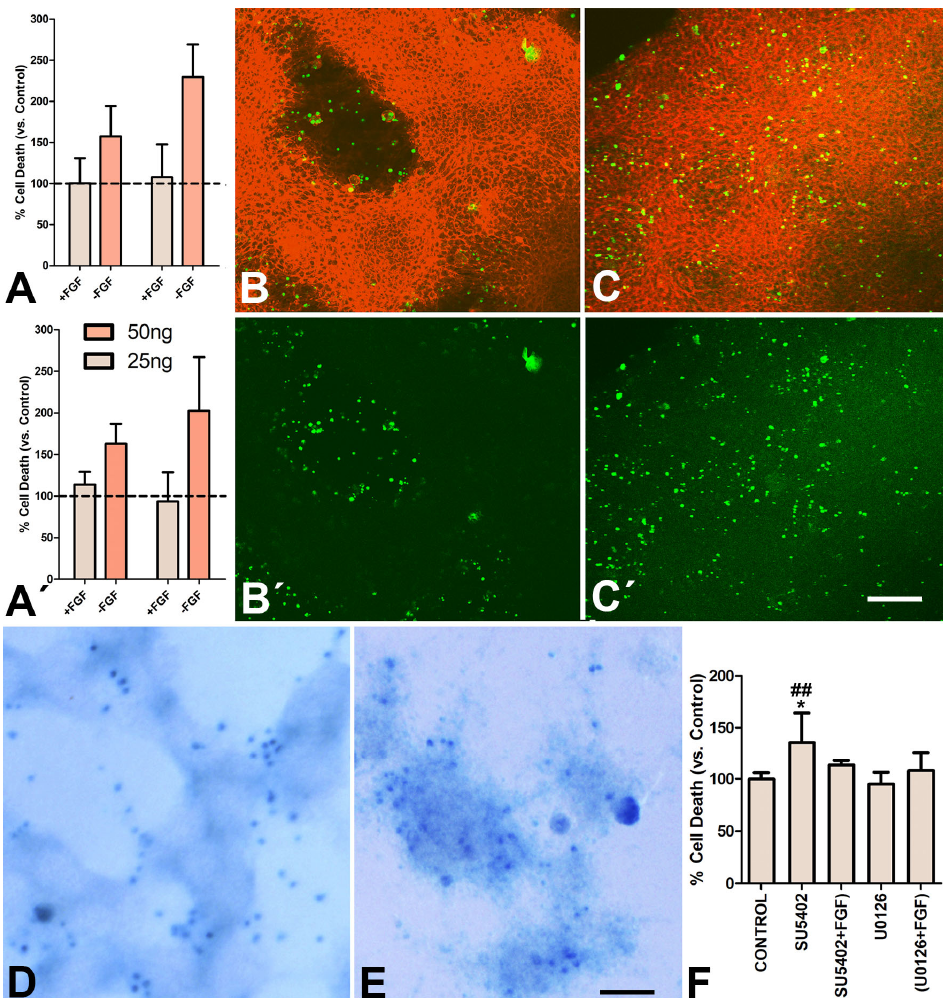
Figure 3. (A – A’) Graphic representation of the rate of cell death evaluated by flow cytometry in cultures treated for 2 days with 25 (light columns) or 50 ng/mL of FGF2 (red columns) to compare the effects of a continuous treatment with FGF (+FGF) and the effect of FGF withdrawal ( ‐ FGF) for 3 h ( A ) or 6 h ( A’ ). The rate of cell death in the control untreated micromasses was considered 100 and is indicated by the dotted line. (B – B’) Confocal view of the perinodular arrangement of TUNEL ‐ positive cells (green labeling) in a labeled control 2 ‐ days culture. The sample is also labeled with phalloidin (red labeling). ( B ) is a merged image, and ( B’ ) shows only the green channel. ( C – C’ ) Confocal view showing the widespread arrangement of TUNEL ‐ positive cells (green labeling) after 3 h of FGF withdrawal in micromasses treated for 2 days with FGF2 (25 ngr/mL) . Red labeling corresponds to phalloidin. ( C ) is a merged image, and ( C’ ) shows only the green channel. ( D , E ) Detailed view of the SA β‐ gal arrangement in control ( D ) and experimental micromasses subjected to FGF ‐ withdrawal ( E ). Note the perinodular distribution of SA β‐ gal in the control in contrast with the intranodular distribution in the experimental culture. ( F ) Graphic representation of the rate of cell death evaluated by flow cytometry in 2 ‐ day micromasses subjected to treatments with SU5402 (800 ng/mL), SU5402 plus 25 ng/mL of FGF2, U0126 (7.6 ng/mL), and U0126 plus FGF2. Scale bar in B − C´ = 250 μ m; scale bar in D − E = 50 μ m. * p < 0.05 (versus control); ##, p < 0.01 (versus SU5402+FGF2).